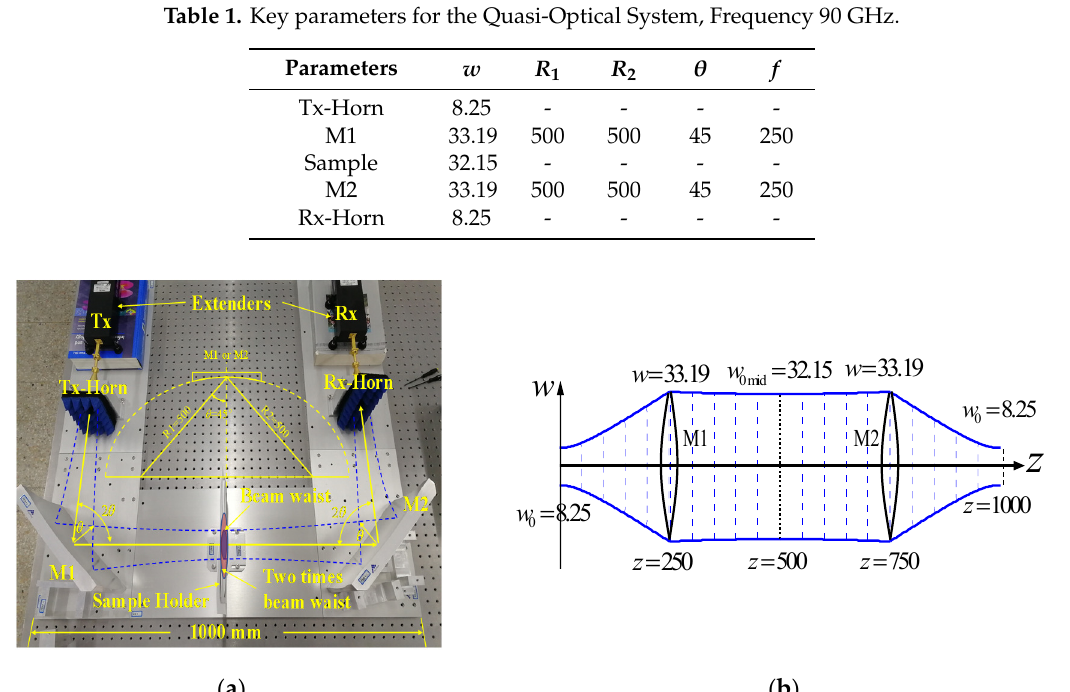
Figure 3. The photograph of the quasi-optical system for dielectric measurement. ( a ) The photograph, ( b ) the beam waist as beam propagation.